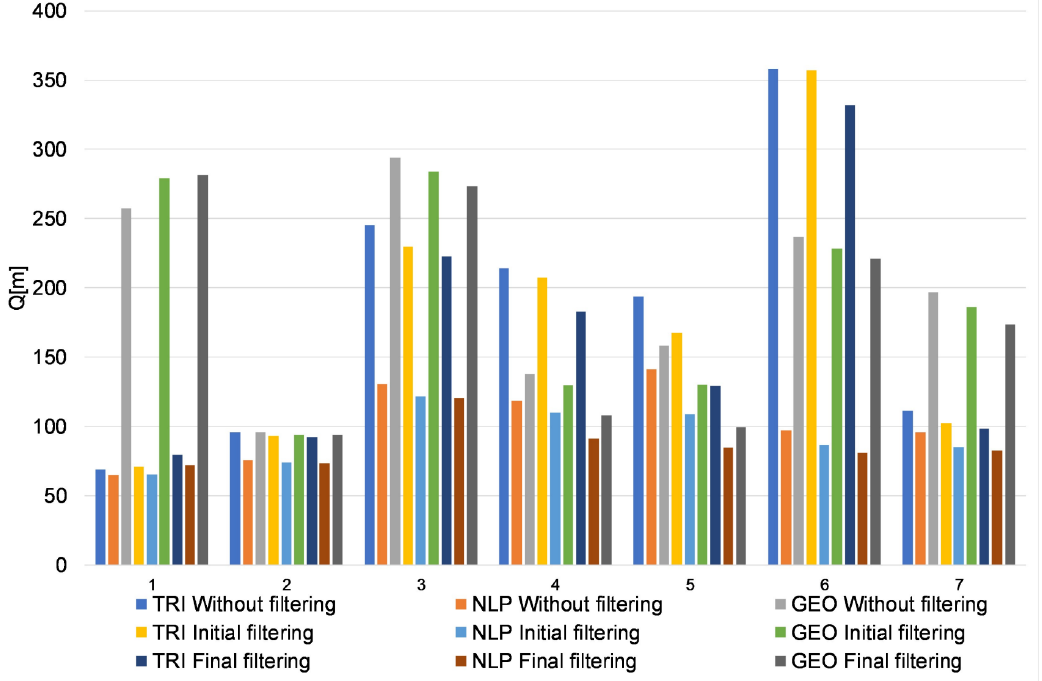
Figure 22. Results of the quality indicators Q for trajectories 1–7.